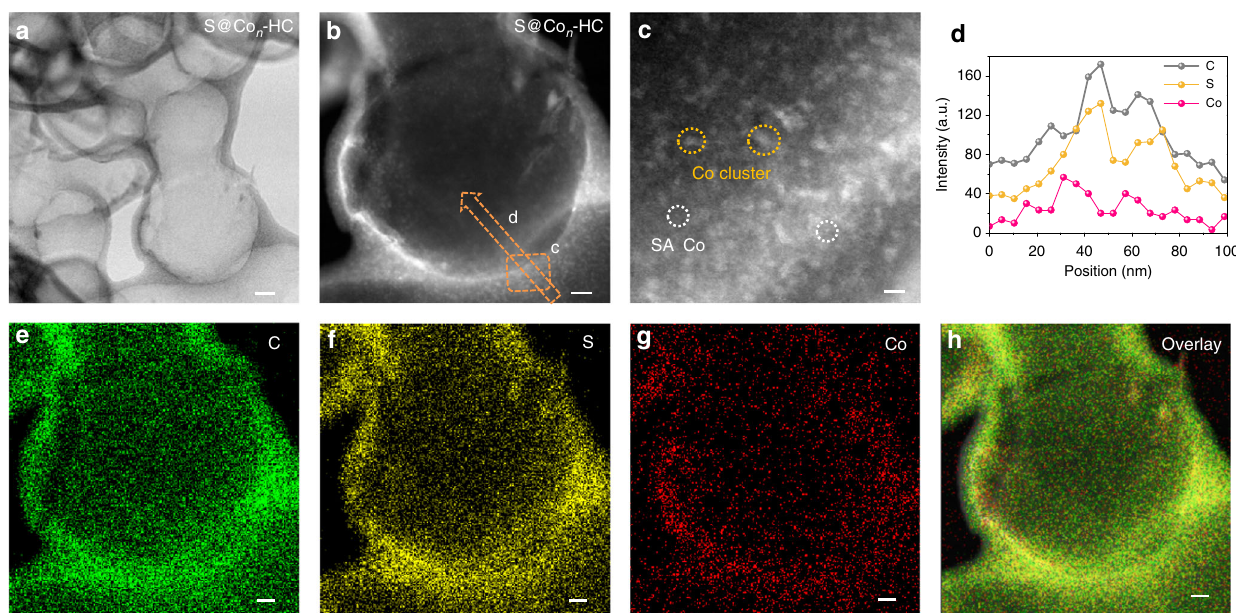
Fig. 2 Representative electron microscopy images. a Transmission electron microscopy (TEM) image, b , c high-angle annular dark fi eld (HADDF)-scanning tunneling electron microscopy (STEM) images of atomic cobalt-decorated hollow carbon sulfur host (S@Co n -HC). Scale bar, 20 nm ( a ), 10 nm ( b ) and 2 nm ( c ). d Line-pro fi le analysis from the area indicated on ( b ). e – h Elemental mapping of S@Co n -HC. Scale bar, 10